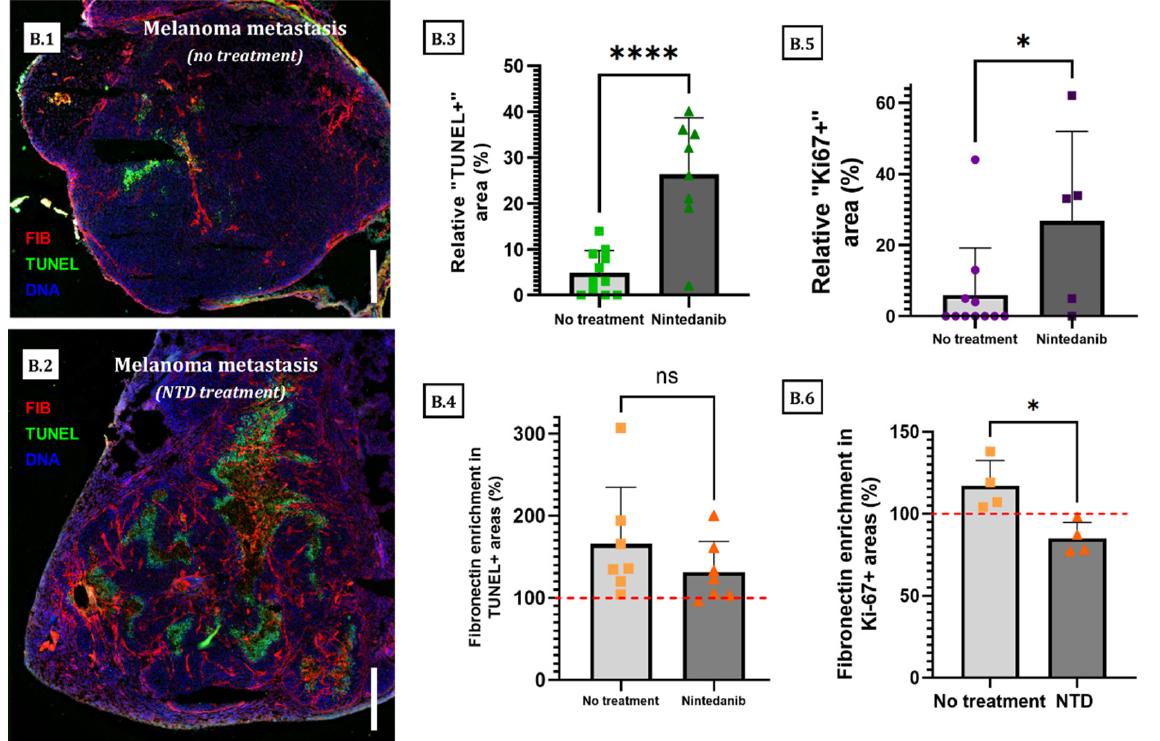
Figure 8. Effects of Nintedanib on the ECM composition, proliferation, and tumor necrosis of MEL macrometastases. ( A.1 ) Representative fluorescent images of acellular tumor sections (20 µ m) after immunostaining of laminin (yellow), collagen IV (green), collagen I (blue), and fibronectin (red). Healthy lung ECM is represented in the left column. ECM-rich areas (%r, white selections) were traced using a phase contrast image and then applied to the corresponding fluorescent image. ( A.2 , A.3 ) ECM proteins’ fluorescent signal quantification of the total tumor (%t) and tumor ECM-rich areas (%r). Healthy lung ECM signal was normalized to 100% (green line). ( B ) Effect of Nintedanib treatment on tumor necrosis (TUNEL) ( B.1 – B.4 ) and proliferation (Ki67) ( B.5 , B.6 ). TUNEL+ and Ki67+ areas were quantified in ( B.3 , B.5 ), respectively. ( B.4 , B.6 ) Fibronectin enrichment in ( B.4 ) TUNEL+ areas and ( B.6 ) Ki67+ areas 100% corresponds to the total tumor measurement. Statistical analysis was performed using unpaired parametric student’s t -tests (ns, p -value > 0.05 *, p -value < 0.05, ****, p < 0.0001). Scale bar = 500 µ